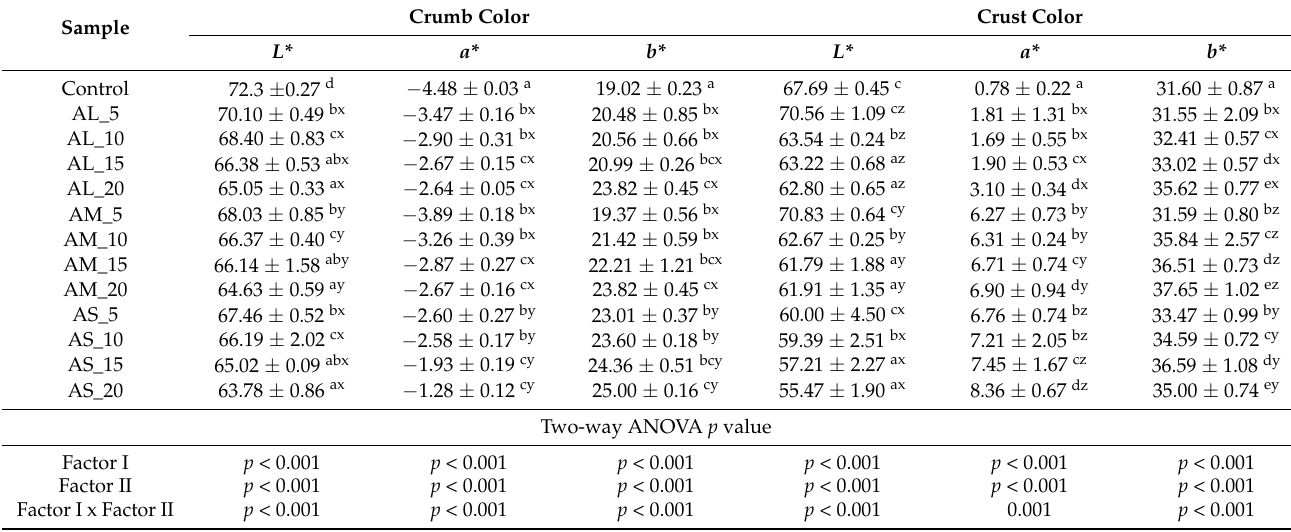
p < 0.001 p < 0.001 0.001 p < 0.001 Factor I—level of AF addition; Factor II—type of PS. Mean values in the same column followed by different letters are significantly different ( p < 0.05): a–e for AF different addition level containing samples (0–20%); and x–z for AF different particle size containing samples (L, M, and S). L* —lightness, a* —greenness (negative) or redness (positive), and b*